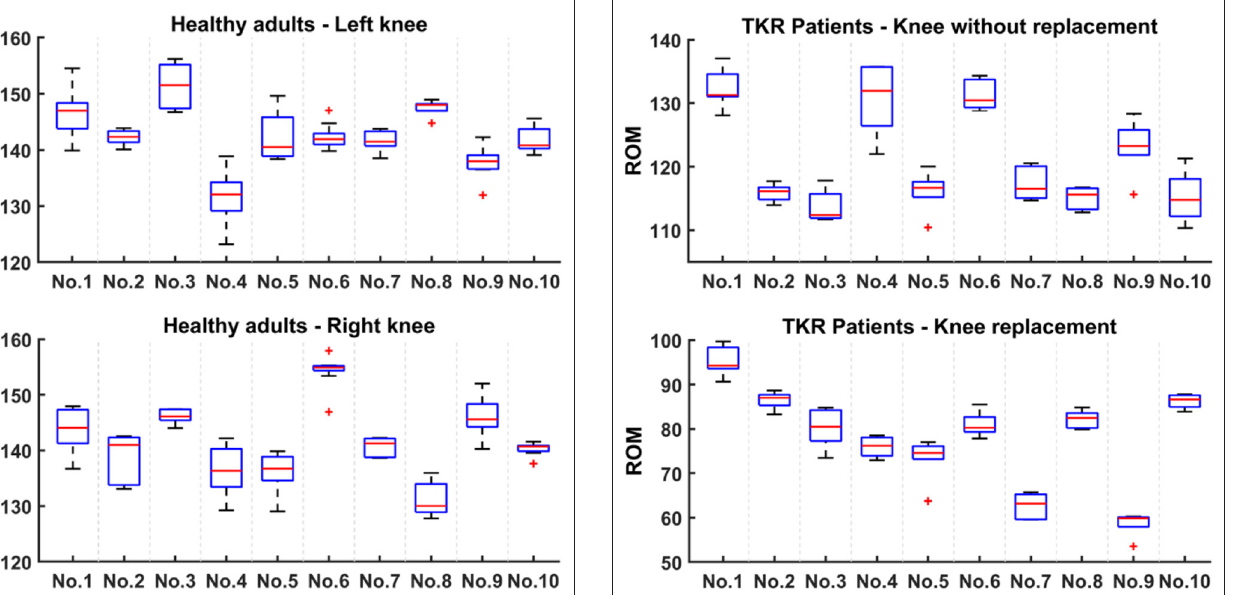
FIGURE 6 | Knee ROM of healthy subjects. They are divided into left and right knee.